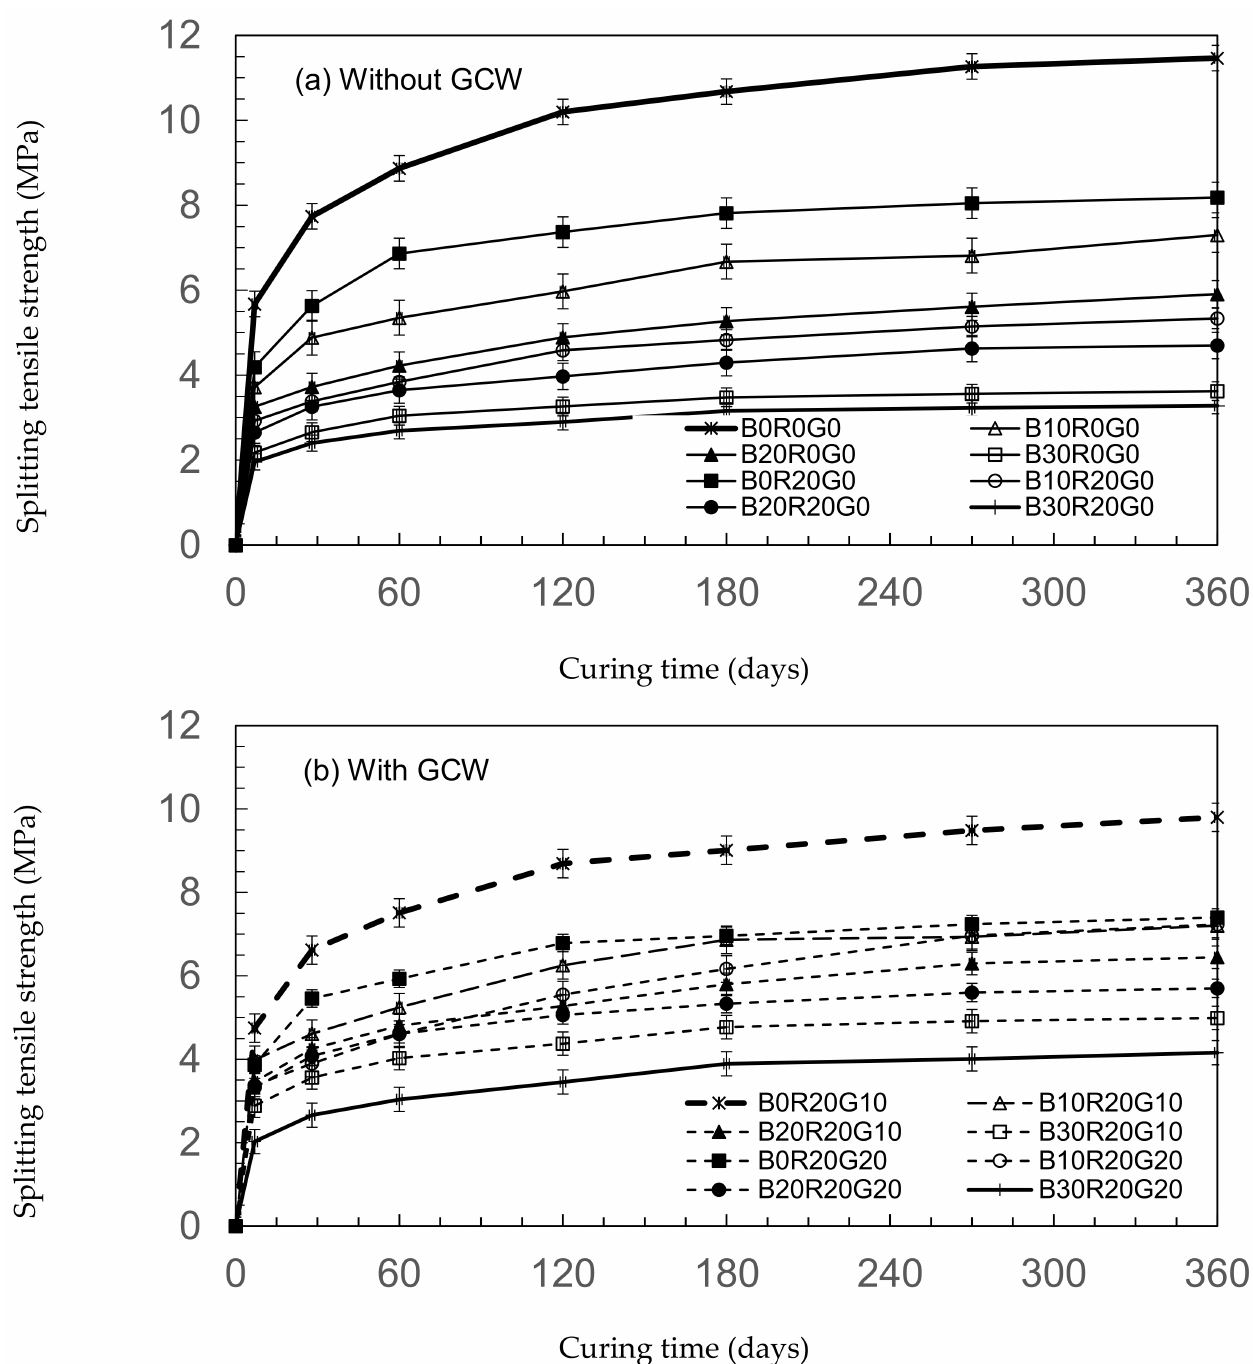
Figure 4. Splitting tensile strengths of gSCC. ( a ) without GCW and ( b ) with GCW. As a proportion of compressive strengths, the splitting tensile strengths for gSCC are indicated in Figure 5. In gSCC, these percentages varied from 8.5 to 15%, which are the same as those of conventional concretes. Beixing et al. [27] noted that the proportions of the concrete splitting tensile strengths integrating BA were in the range of 10–12% of compressive strength. Additionally, the findings and results reinforce those of previous studies, showing that the plain concretes’ splitting tensile strengths were about ten percent of their compressive strengths. The results indicate that the splitting tensile strength increases linearly with increasing compressive strength